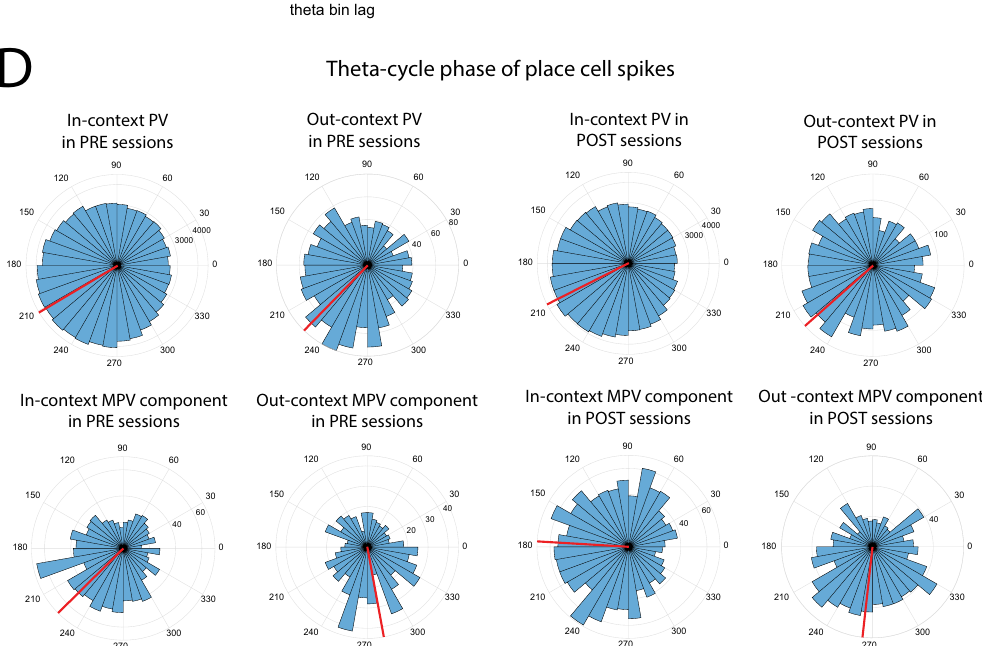
Figure 4. Properties of the identified activity patterns. ( A ) Example of temporal distribution of classified activity patterns during one of the POST sessions from an experimental group animal. Top: out-context PV, middle: mixed PV, bottom: in-context PV. le MPV and red OCPV; vertical separation of activity types serves for better visual differentiation of activity instances. ( B ) Out-context PV incidence auto-correlogram. The values were z-scored using random distribution and then averaged across sessions. ( C ) Deviation between the decoded and actual position of the animal across OCPV and ICPV. The out-context PV events demonstrated higher position error than the ICPV events. ( D ) Distribution (blue) and average (red) theta phase of spikes from identified in-context, out-context, and mixed population vectors. The bar length represents the number of PVs in the respective phase interval. Phase values are normalized to the individual identified phase border between the theta bins (see the Methods section). Spikes from OCPV appeared in significantly later phases of the theta cycle than ICPV. The in-context and out-context activity components of the mixed PVs appeared in significantly different portions of the theta